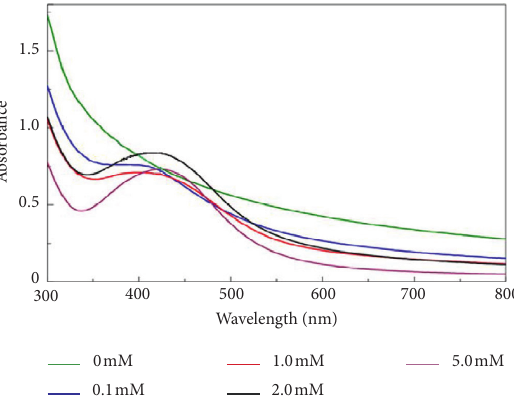
Figure 5: UV-vis spectra of glycerol solutions containing 2g SiO